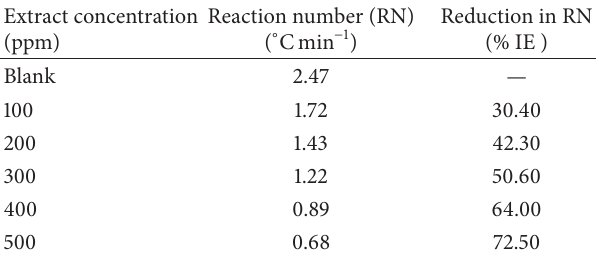
and (6) 500 ppm. Table 2: Calculated values of reaction number and percentage reduction in RN for Zn dissolution in 1.0 M HCl containing marjoram extract from thermometric